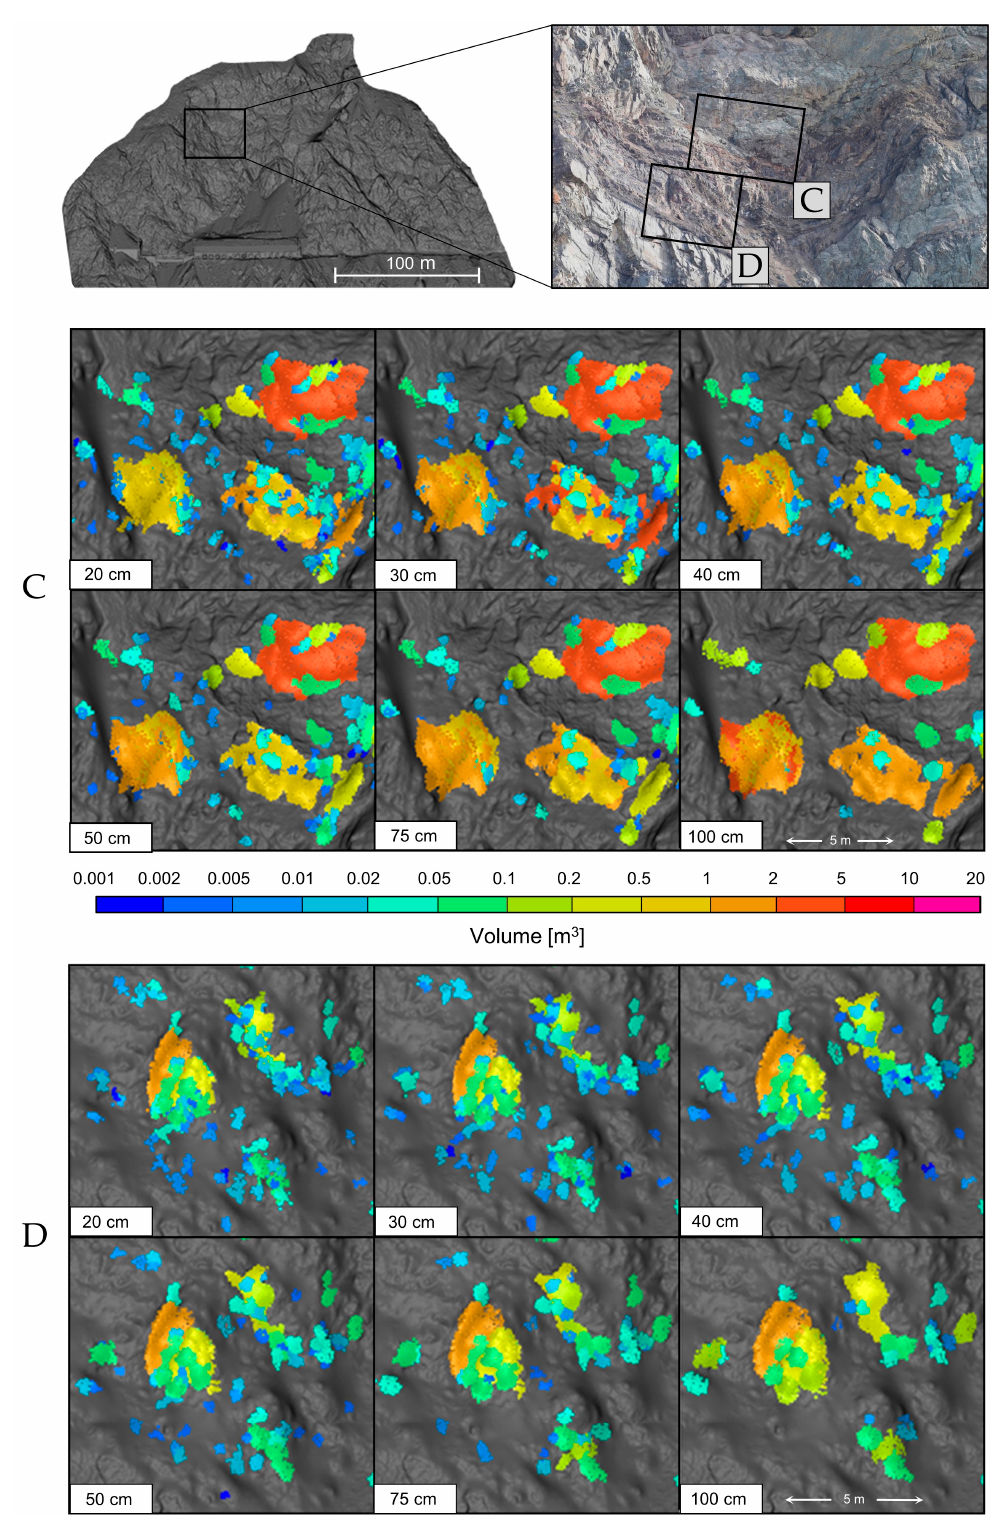
Figure 14. A second depiction of the effect of spatial averaging on the rockfall inventories as a result of increasing the M3C2 projection diameter. Individual rockfall point clouds are colorized by binning their volume as shown in the color scale. Cooler colors indicate smaller volumes and warmer colors indicate larger volumes. Each cluster of a distinct color represents a single rockfall event. All change detection timesteps are plotted at